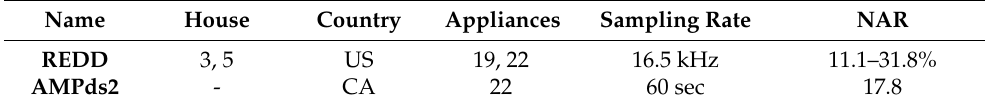
Table 1. Short description of the REDD and AMPds2